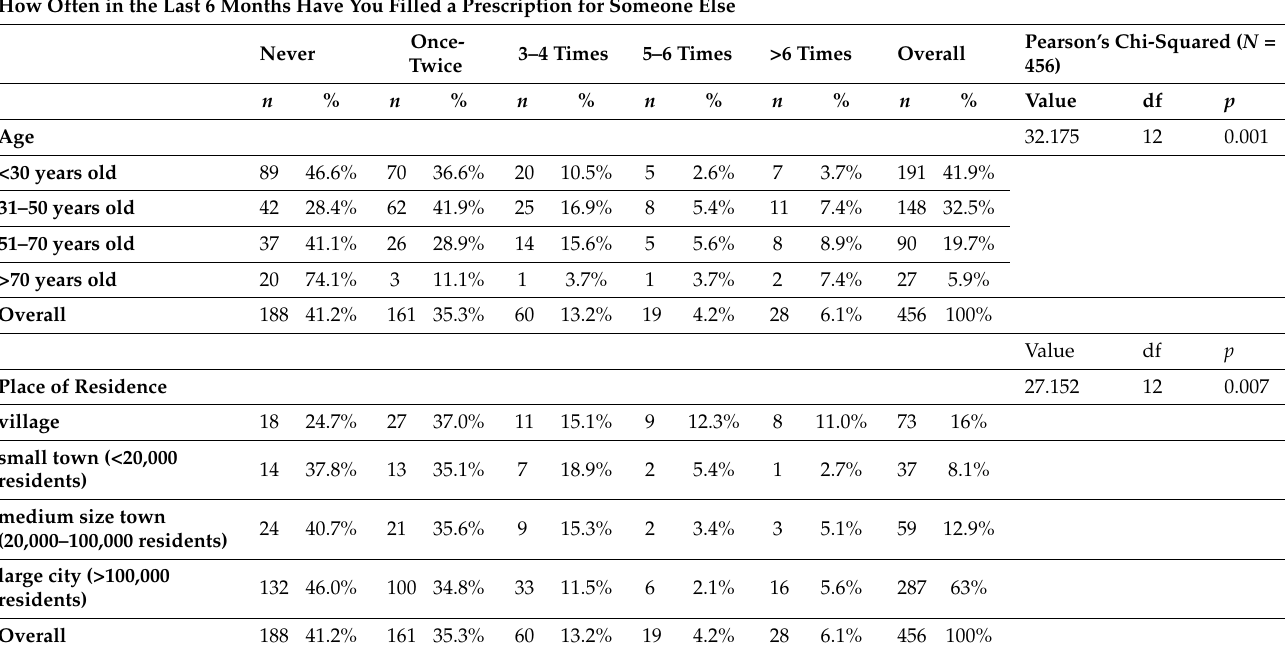
Table 2. Table showing the numerical and percentage distribution of responses to the question “How often in the last six months have you dispensed a prescription for another person” by age and in relation to place of residence.